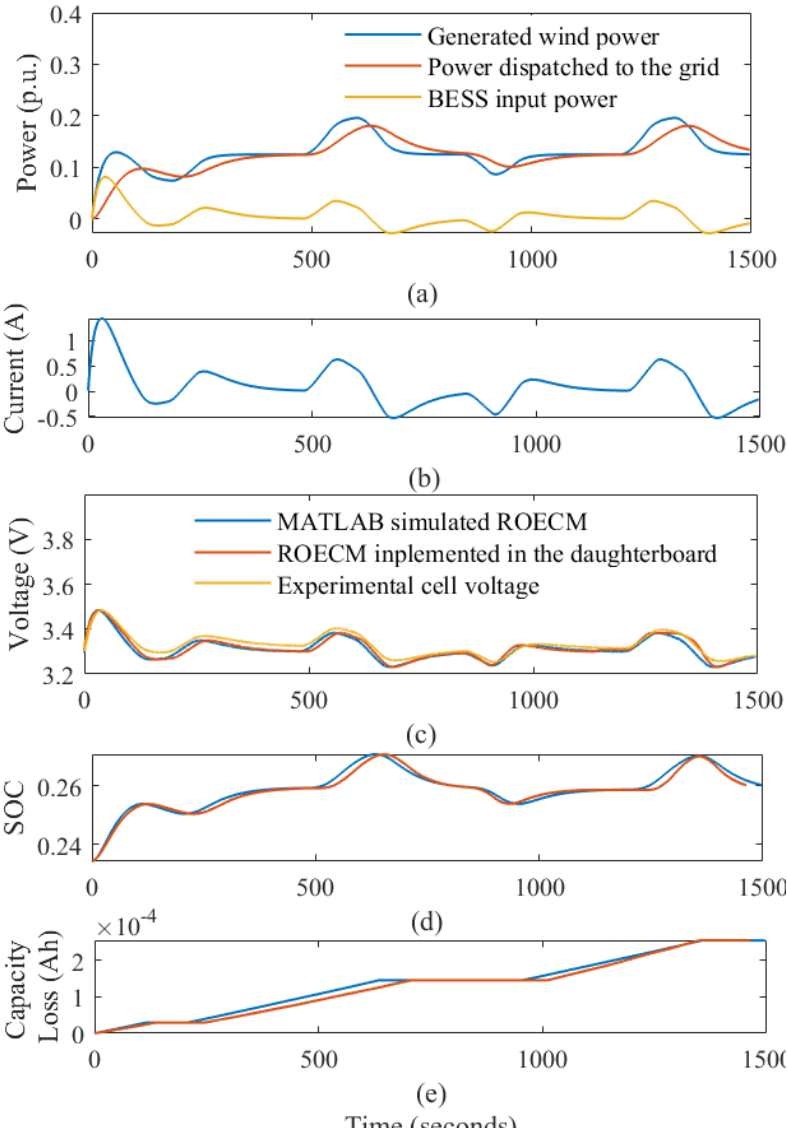
Figure 11. Experimental and MATLAB simulation results of battery state estimation in the daughterboard-embedded battery